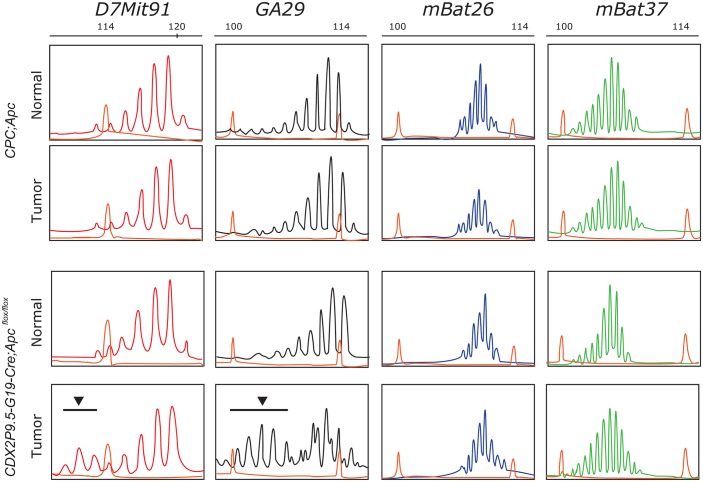
MSI in tumors from CPC;Apc and CDX2P9.5-G19Cre;Apc
flox/flox mice.Tumors from CDX2P9.5-G19Cre;Apc
flox/flox mice showed a hypermutable phenotype (arrowhead and black bar) for two (D7Mit91 and GA29) of four markers investigated, suggesting that tumor development occurs via MSI. The 600 LIZ size standard (Eurofins GeneScan, Frieburg, Germany) was used as a marker for sizing DNA fragments.